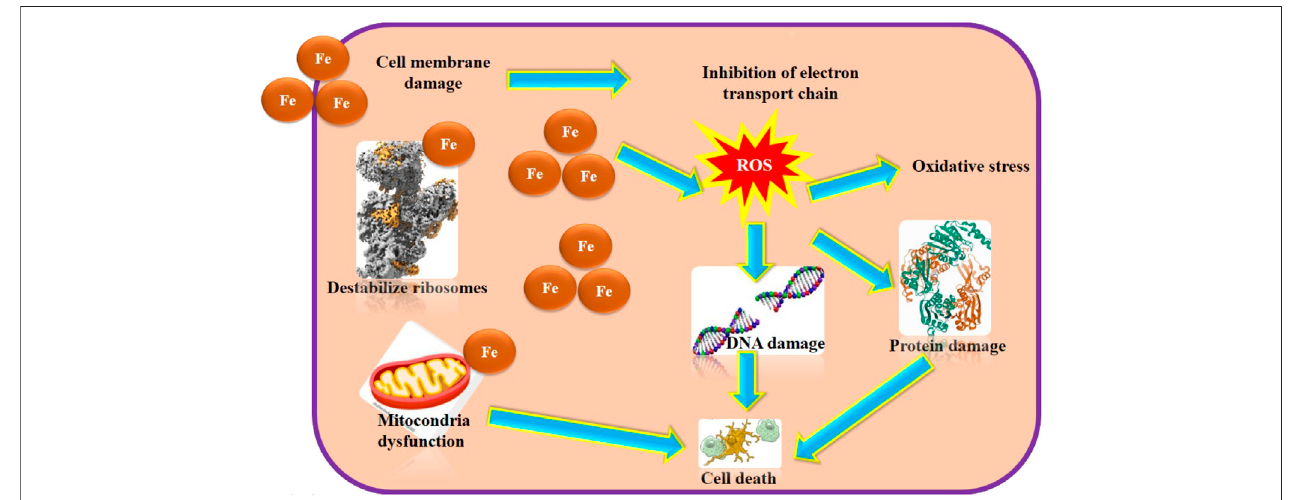
FIGURE 3 | Schematic mechanism for the antibacterial activity by Fe